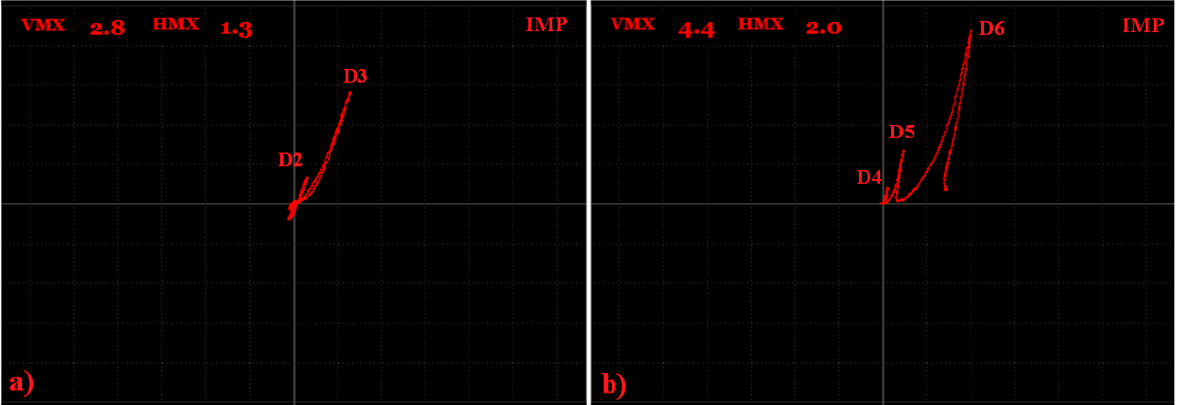
Figure 12. S2 sample, signal-to-size of defect variation; ( a ) D2 and D3 defects at 90 kHz excitation frequency; ( b ) D4-D6 defects at 5 kHz.